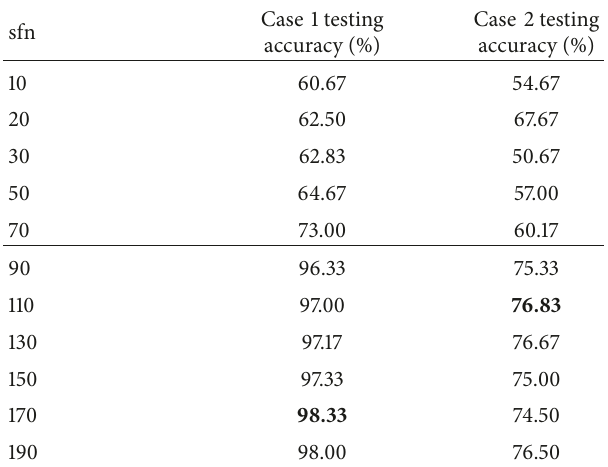
Table 19: Bearing fault diagnosis results obtained by the OFS- FSASD-SVM.